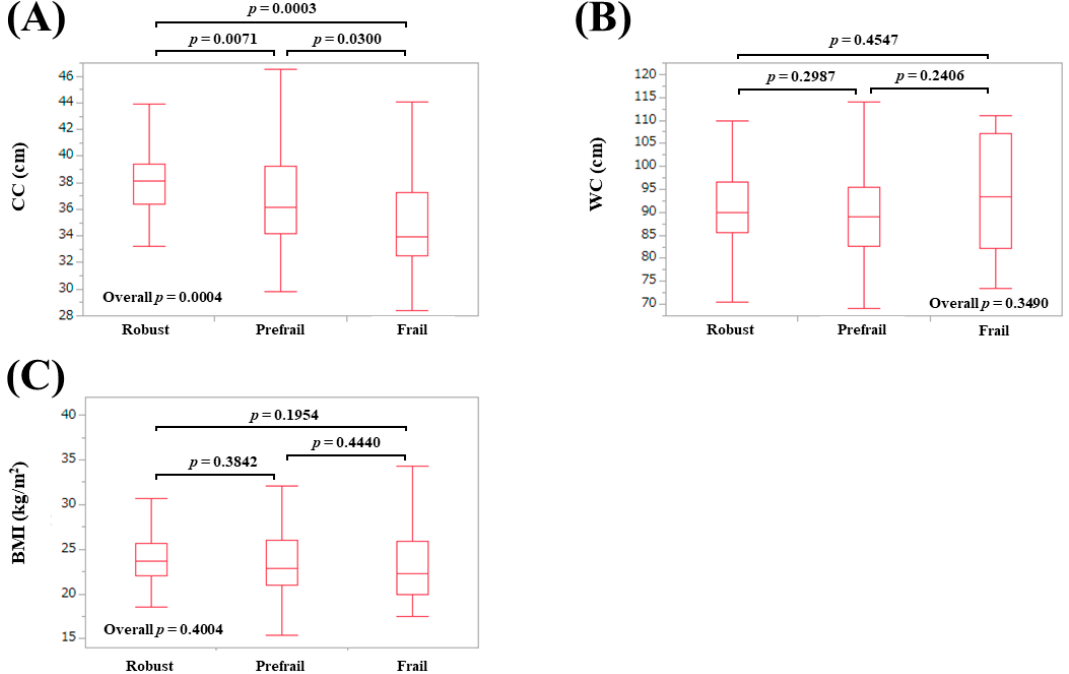
Figure 2. Anthropometry measurements according to frailty status in male participants. ( A ) Calf circumference; ( B ) Waist circumference; ( C ) Body mass index.